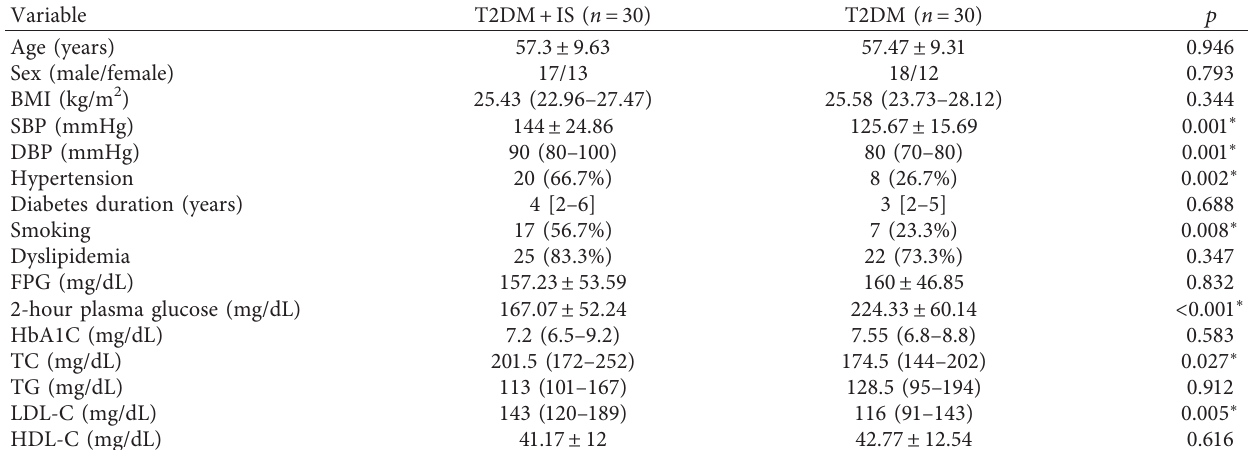
Table 1: Demographic, clinical, and biochemical data of the participants.